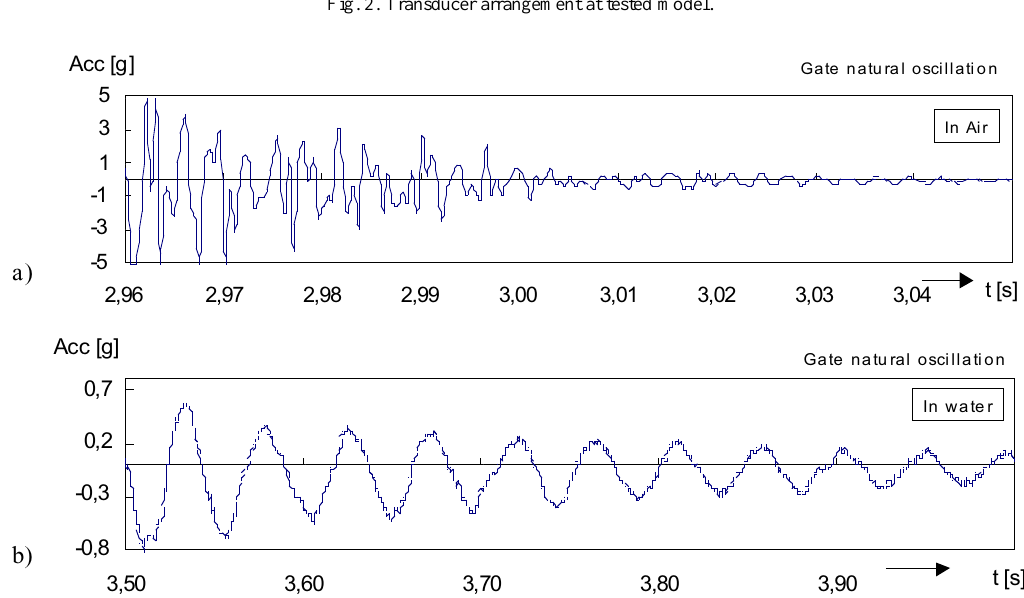
Fig. 3. Time history records of the gate natural oscillation in air (a) and in water